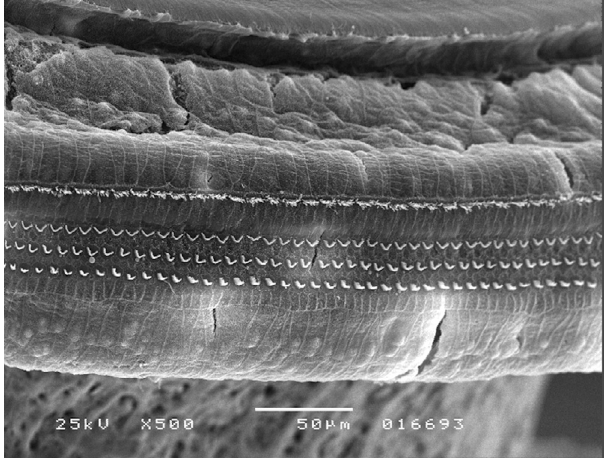
Photo from Sound group (scanning electronic microscopy), depicting no injuries to outer hair cells, 500 ×